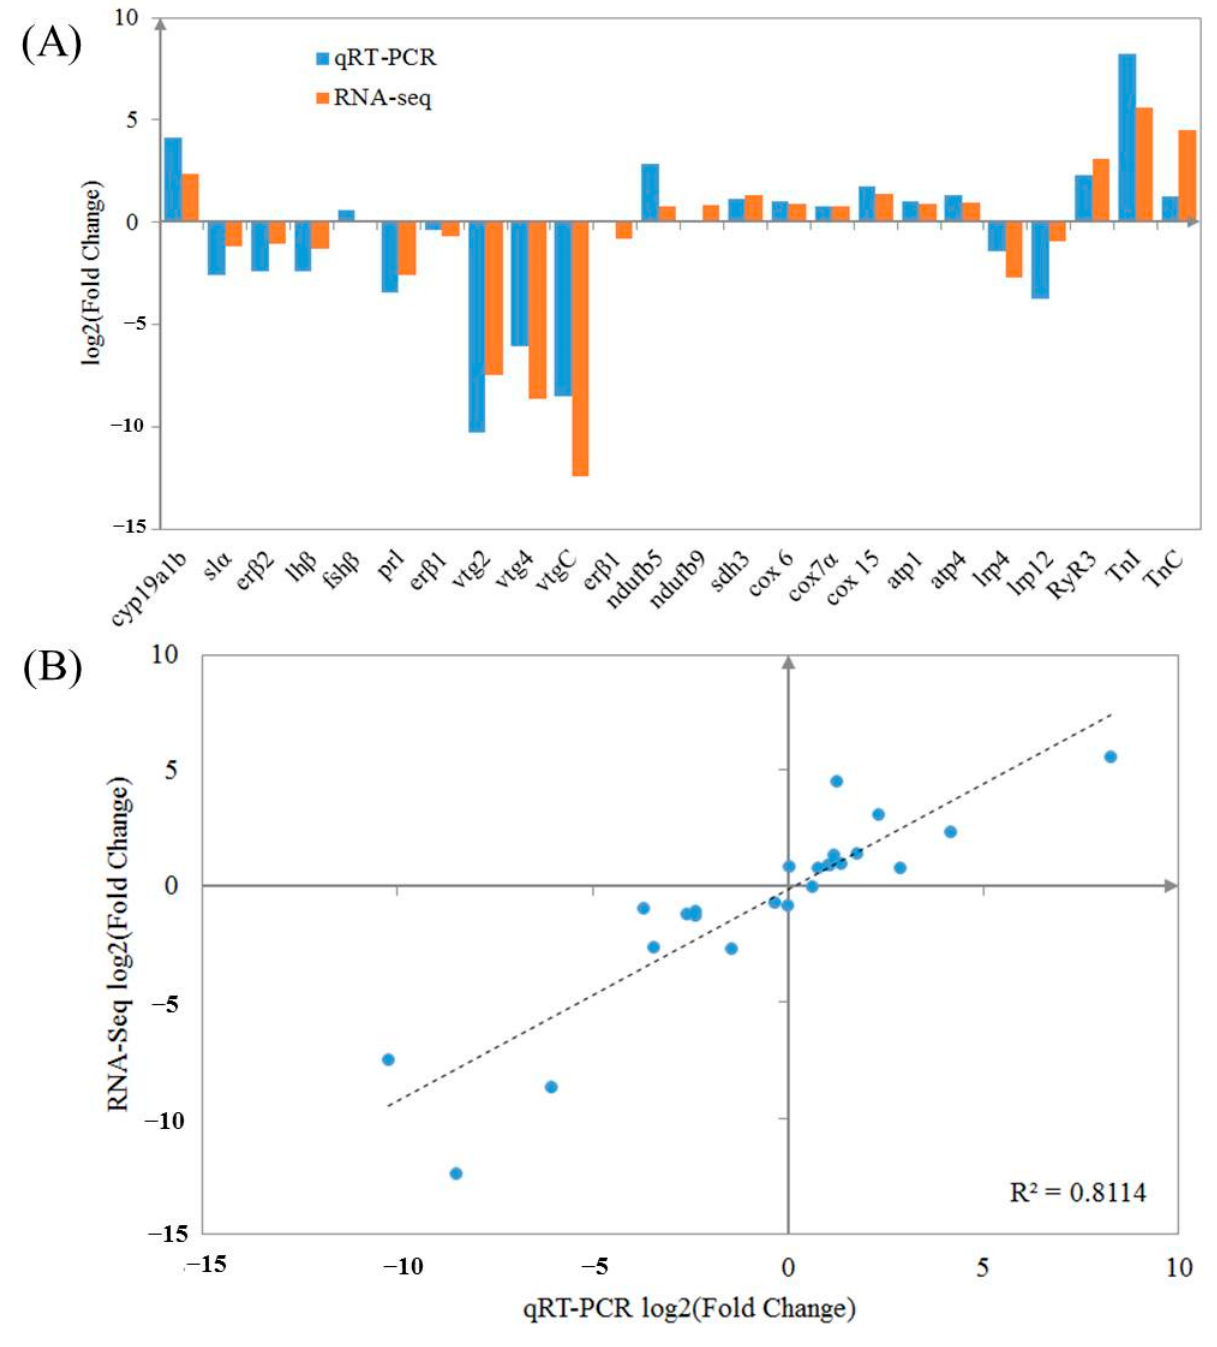
Figure 5. The expression tendency of 24 differentially expressed genes detected by RNA-Seq and